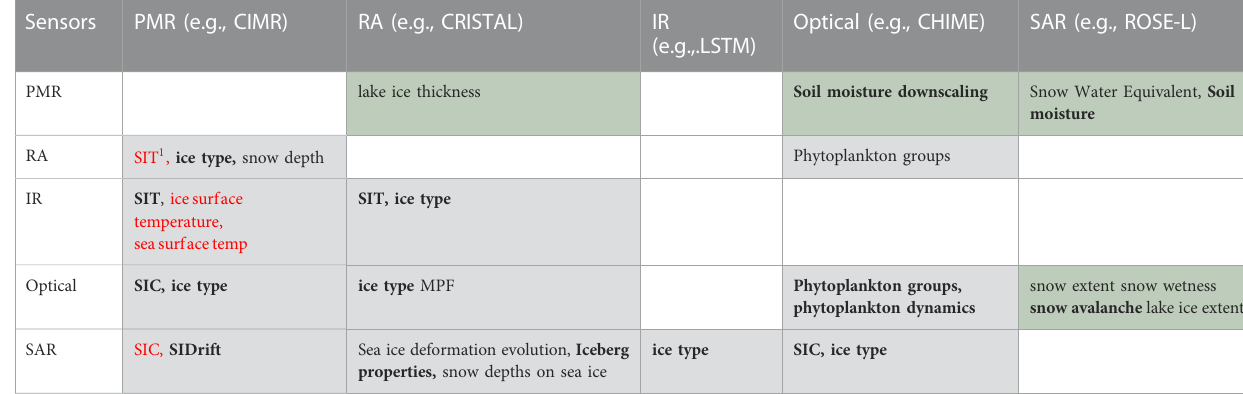
TABLE 1 Matrix of potential synergies that could be put on operation with current and future Copernicus satellites. The synergies mentioned are already tested experimentally.Thegreenboxesaresynergiesforlandapplications,lightgrayforiceandseaapplications.TextinredmeansanoperationalproductinCopernicus phase 1 (2021). Parameters with high impact for intermediate and end-users are marked with